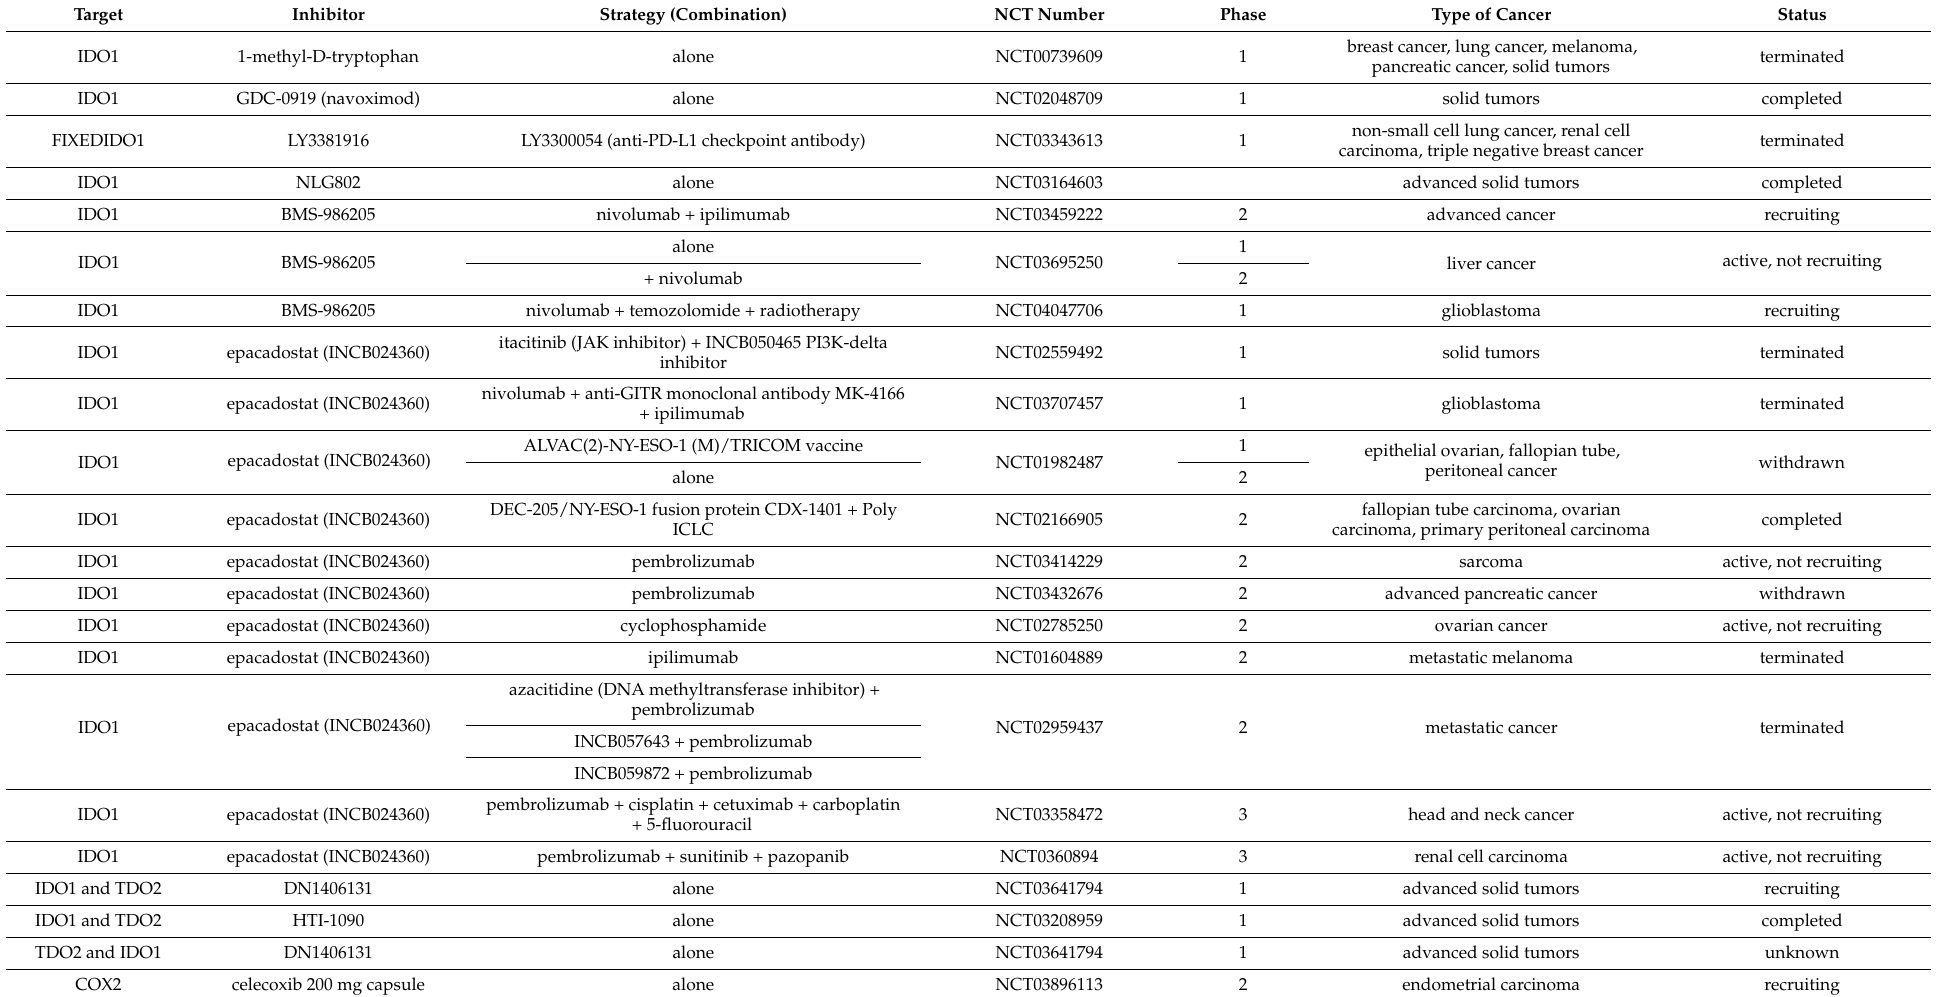
Table 1. List of clinical trials with anti-cancer drugs targeting COX-2, IDO1, or TDO2 in various cancers. Taken from https://clinicaltrials.gov/, last accessed 31 August